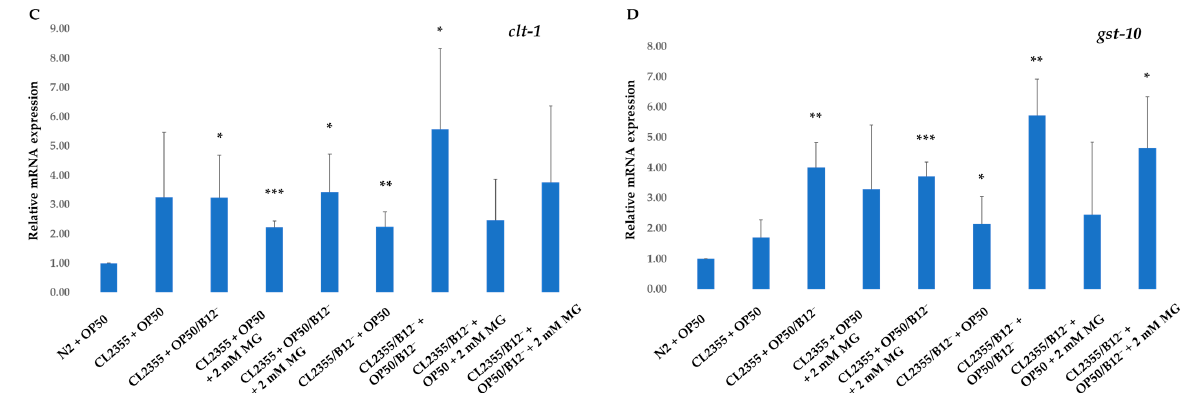
Figure 5. Expression of sod-1 ( A ), gpx-1 ( B ), ctl-1 ( C ) and gst-10 ( D ) genes in CL2355 and CL2355/B12 − worms fed with either OP50 or OP50/B12 − with or without 2 mM mogrosides (MG). The fold-change (2 −ΔΔ Ct ) and standard deviations of the gene expression were calculated from three